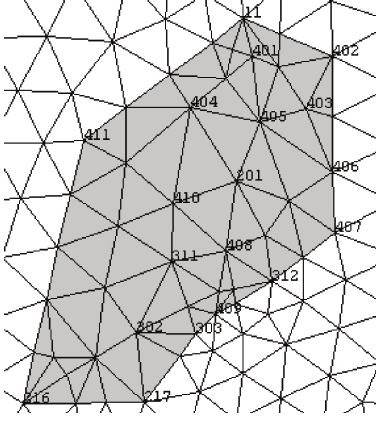
Fig. 2. GPS sites of the Baltic region